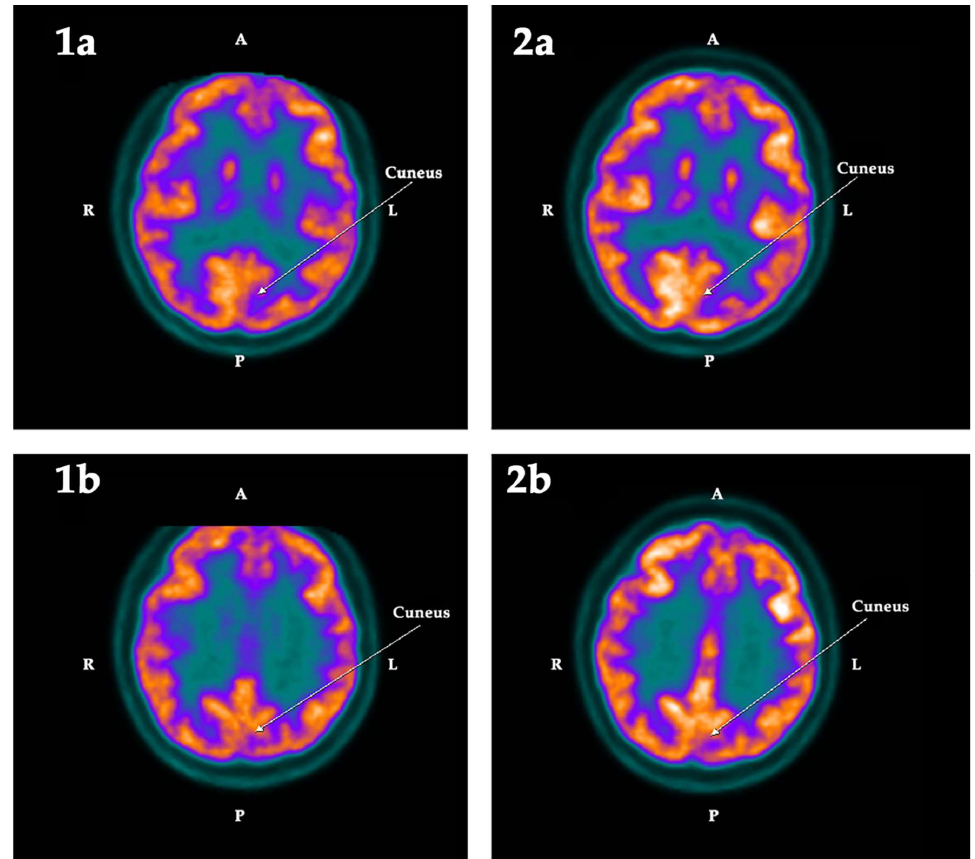
Figure 2. Cross section of the brain showing, in two consecutive sections, the metabolic activity in the left cuneus in the first (1) and the second (2) PET-SCAN studies. Note that the low metabolic activity observed in the left cuneus in the first PET-SCAN ( 1a , 1b ) was normalized ( p < 0.025) after treatment with GH ( 2a , 2b ). A: Anterior. R: Right. L: Left. P: Posterior.